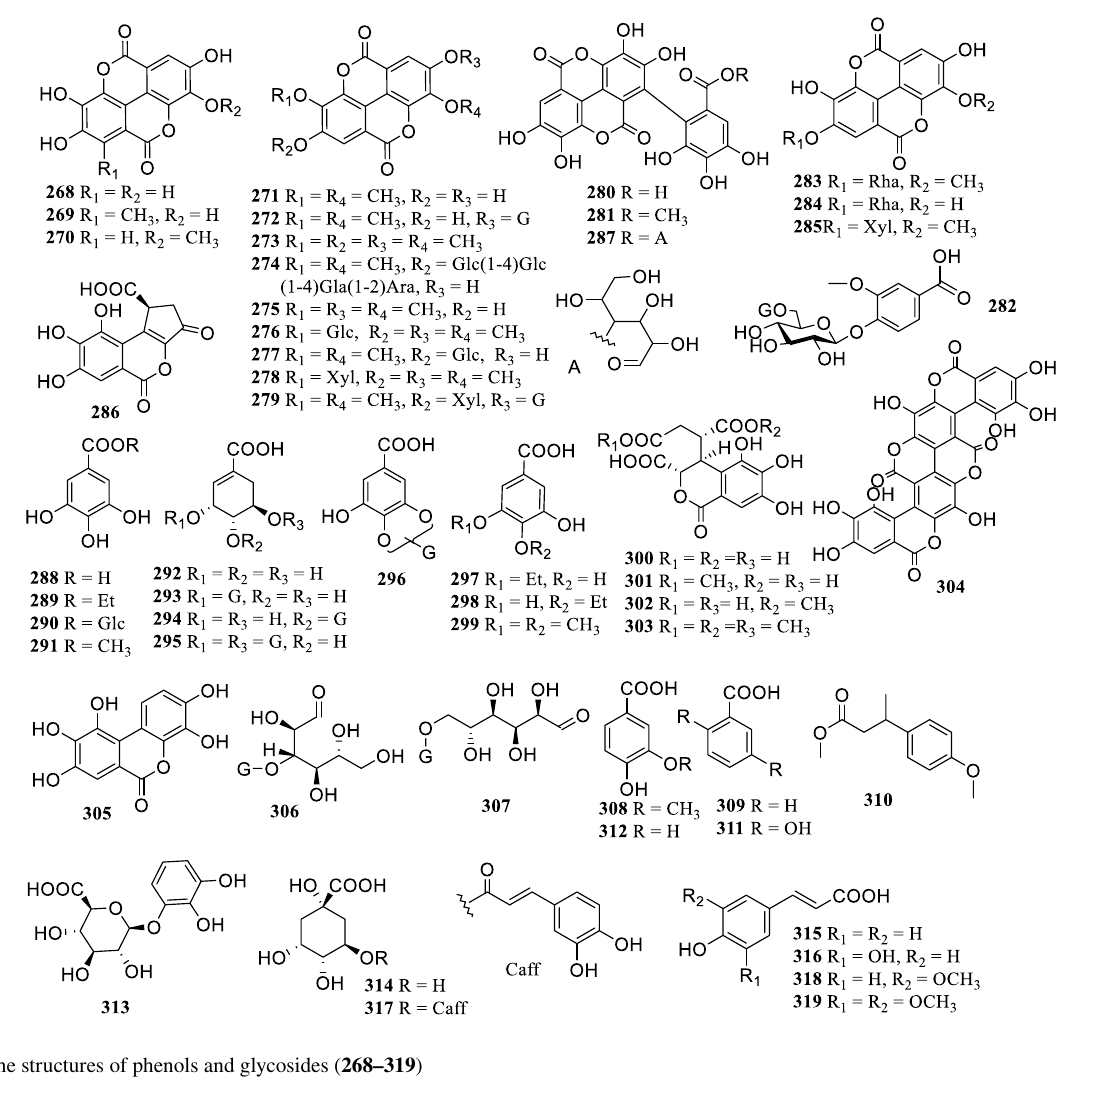
Fig. 5 The structures of phenols and glycosides ( 268–319 )